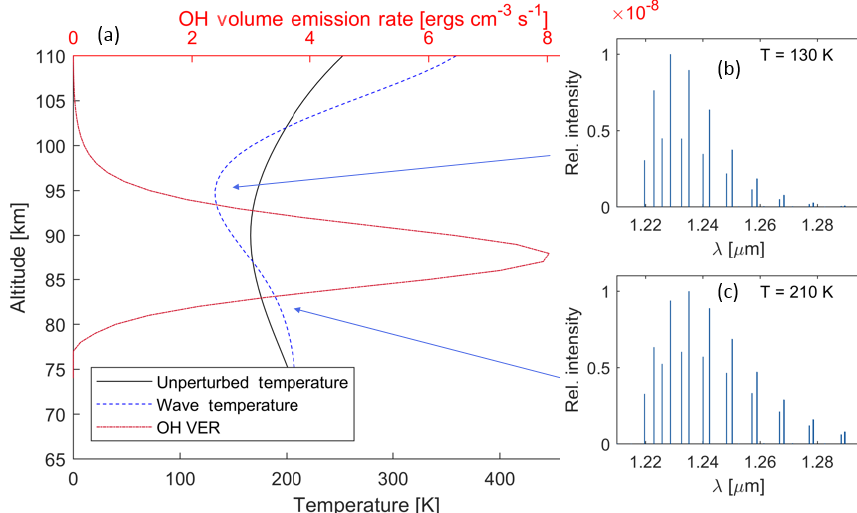
Figure 3. (a) Illustration of the change in the OH airglow spectrum with altitude due to the temperature profile. The red line shows a modelled VER profile of the OH in ergs per cubic centimetre per second (ergscm − 3 s − 1 ). The black line shows the background temperature profile retrieved from the NRLMSISE-00 model. The dashed blue line shows the same temperature profile but perturbed by a wave with an amplitude which has grown to about 30K at 90km altitude and a vertical wavelength of 30km. The insets (b) and (c) on the right show OH spectra of the (7,4) transition at different altitudes for the wave case. Note that, even though the figure shows the P 1 and P 2 lines, only the P 1 lines are considered in the model. With the example wave given here, the temperature variation increases the VER of the lower rotational lines at 95km altitude and of the higher rotational lines at